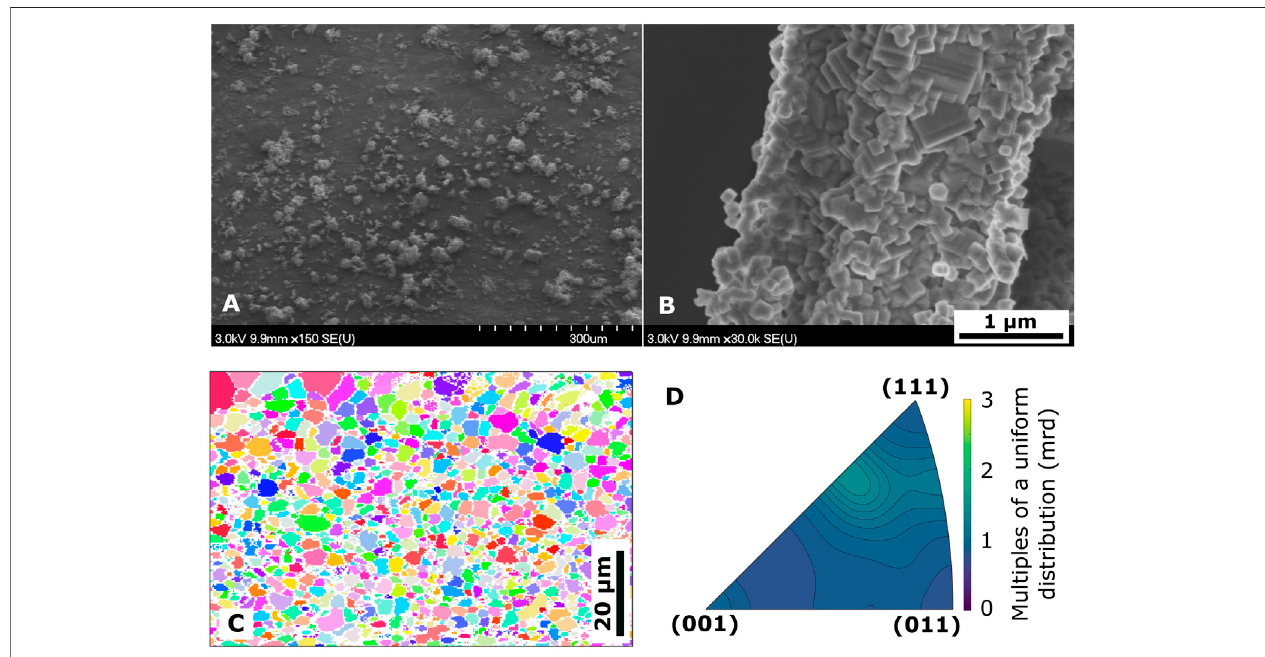
FIGURE 1 | Electron microscopy imaging of MgO starting material. (A) 325 mesh clusters of the original powder. (B) Zoom on one of these clusters. The clusters are made of several smaller crystallites. (C) EBSD orientation mapping of the sample recovered after sintering and annealing at ≈ 2 GPa of hydrostatic pressure and 1,270 K in the D-DIA. The sample is dominated by grains with areas around 3 μ m 2 . (D) Inverse pole fi gure of the compression direction for the reference undeformed sample (D2028).